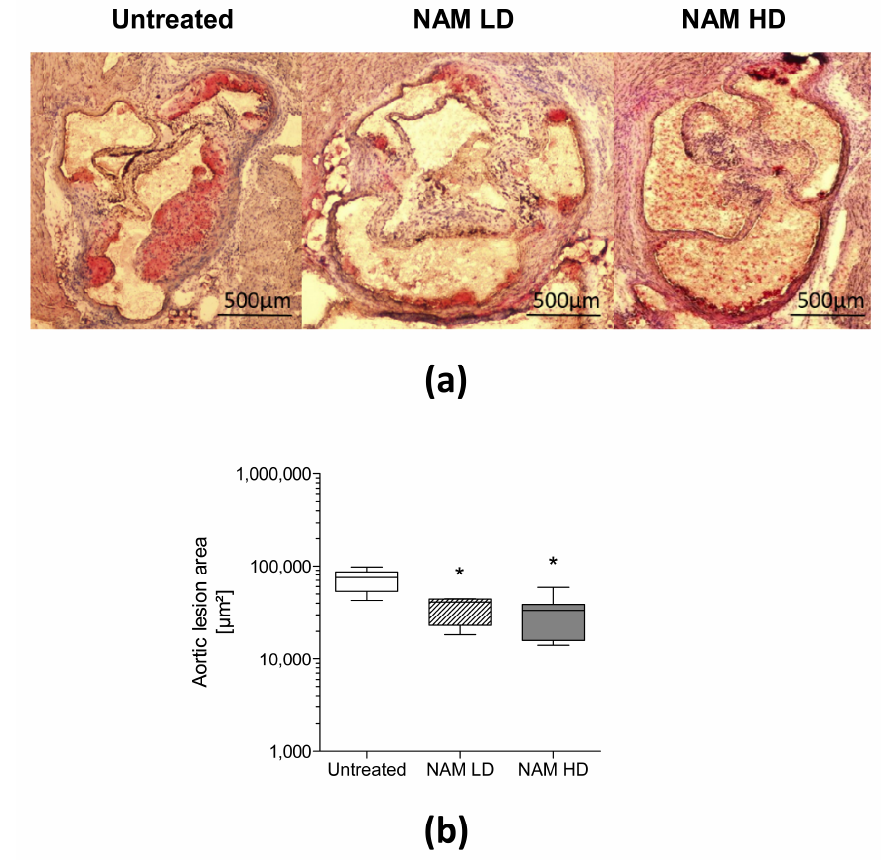
Figure 1. Analysis of proximal aortic lesions in apolipoprotein (Apo)E-deficient mice treated with different doses of NAM. ( a ) Representative images of aortic atherosclerotic lesion in 12-week-old mice challenged to a western diet and NAM over 1 month at 2 months of age. ( b ) Area of proximal aortic lesion quantified from 8 mice per group. Data are expressed as the median (interquartile range) of four consecutive sections throughout the aortic sinus that were obtained every 20 µm when aortic valves became visible. Statistically significant differences among groups for each variable were determined using a nonparametric a Kruskal–Wallis test followed by Dunn’s posttest. Differences were considered significant when p < 0.05. Specifically, * p < 0.05 vs. Untreated group. Abbreviations used: NAM